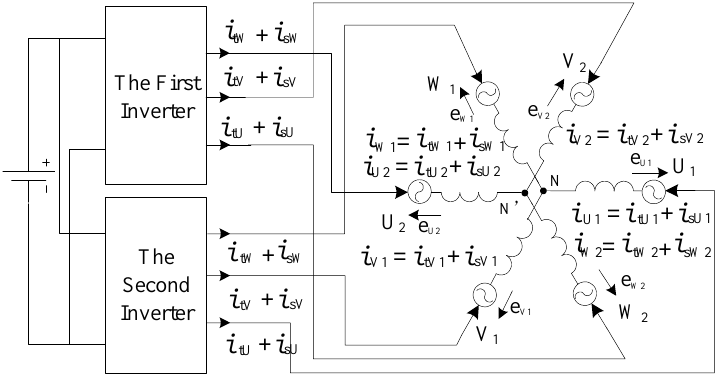
Figure 2. Winding topology of single winding double three-phase BPMSM.